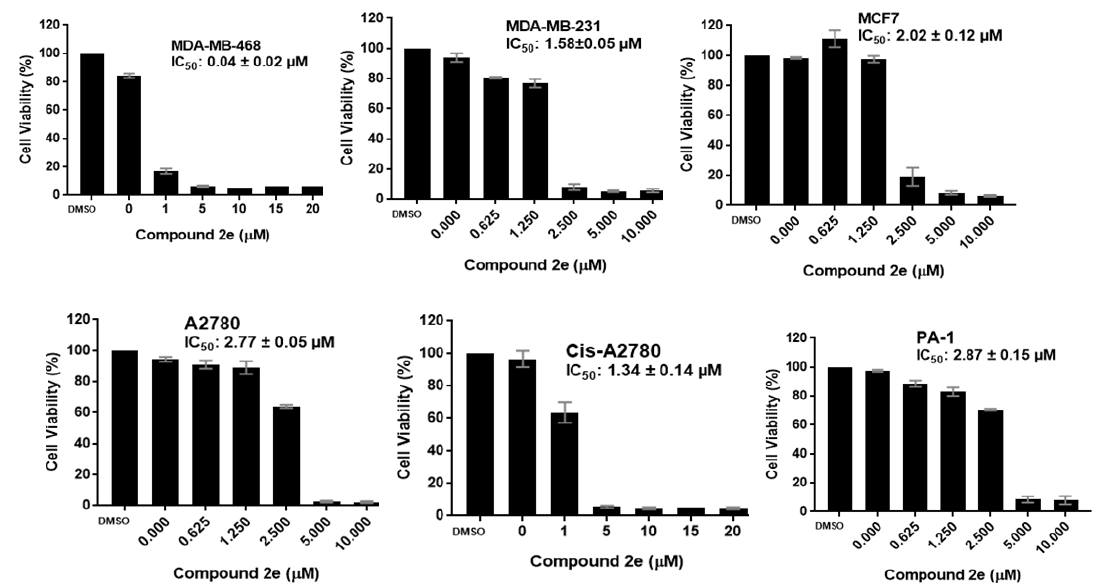
Figure 8. The cell viability (%) relative to untreated control cells of selected breast and ovarian cancer cell lines following the exposure of various concentrations of compound 2e for 48 h.